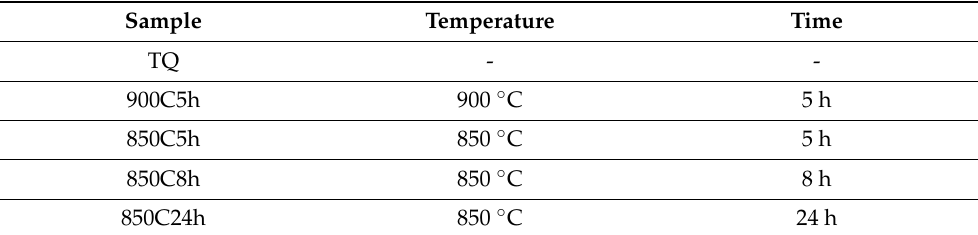
Table 1. Summary of the tested samples.